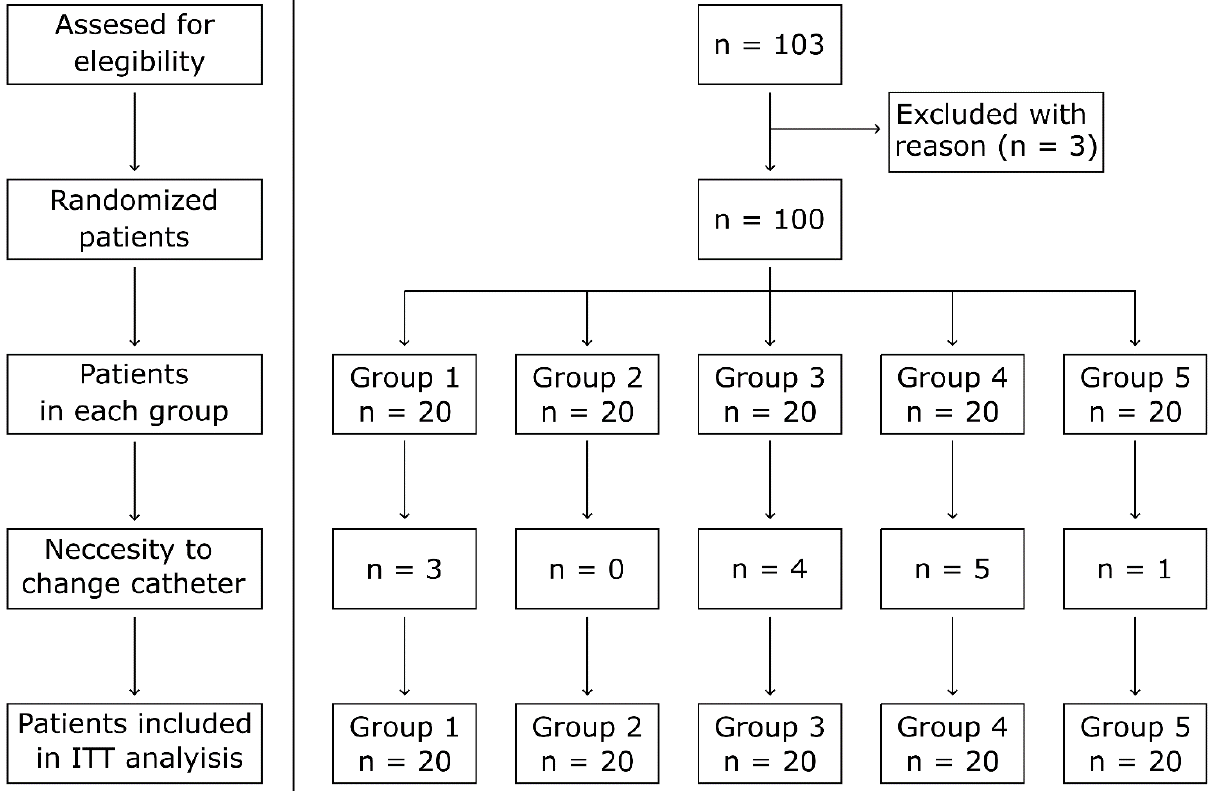
Figure 1. Randomization scheme. ITT — intention to treat; n — number of patients